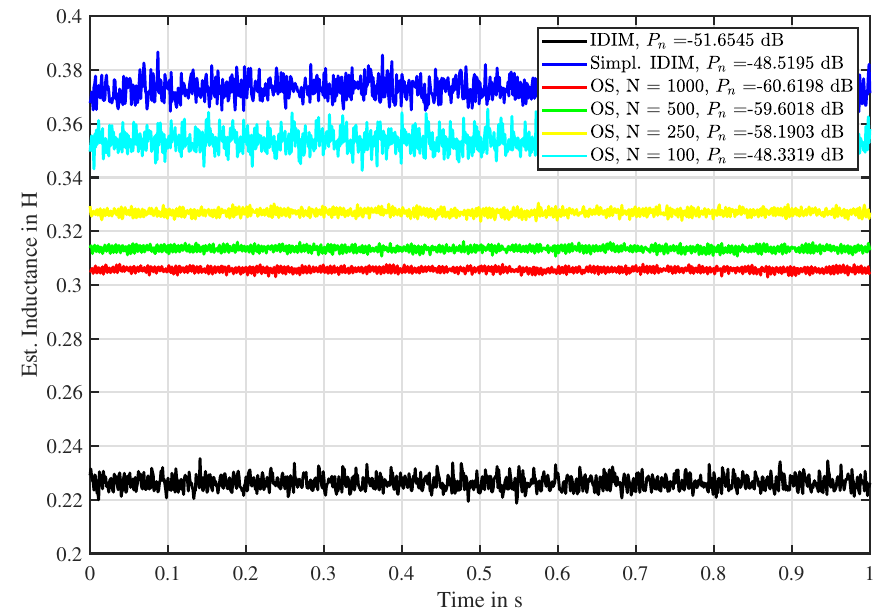
Figure 12. Comparison of the noise power obtained by the different approaches when the actuator is fully opened and under zero mean current